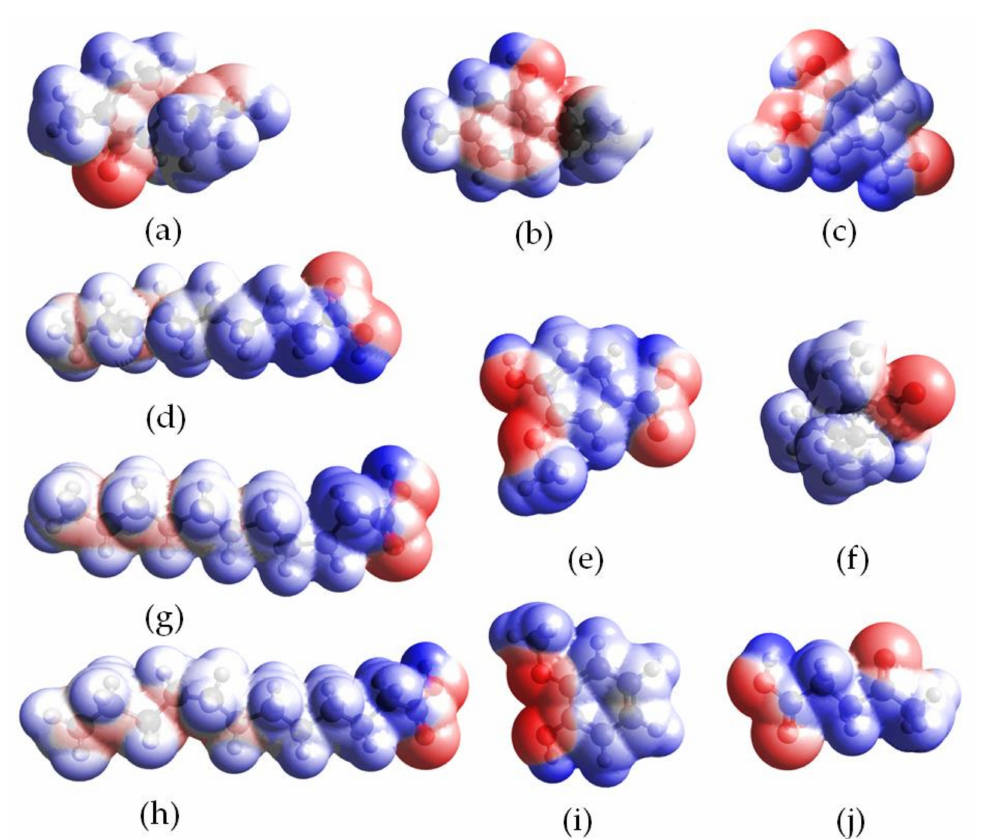
Figure 4. ESP mapped onto total electron density with an isovalue of 0.001 for DES components, i.e., ( a ) carvone, ( b ) thymol, ( c ) vanillin, ( d ) decanoic acid, ( e ) vanillic acid, ( f ) camphor, ( g ) undecanoic acid, ( h ) dodecanoic acid, ( i ) guaiacol and ( j ) levulinic acid. Blue color represents positive charges, red color represents negative charges, and white color represents neutral charges.